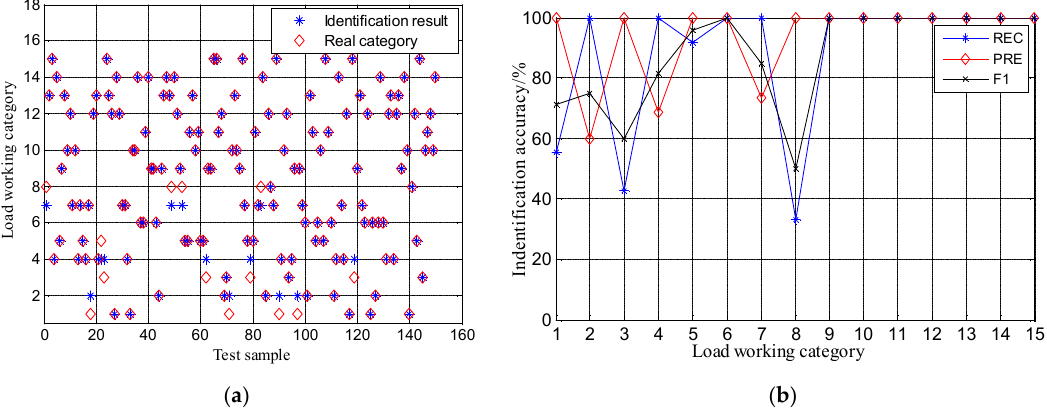
Figure 8. GRNN model identification results and accuracy: ( a ) comparison between recognition results and actual categories; ( b ) identification accuracy of the GRNN model.